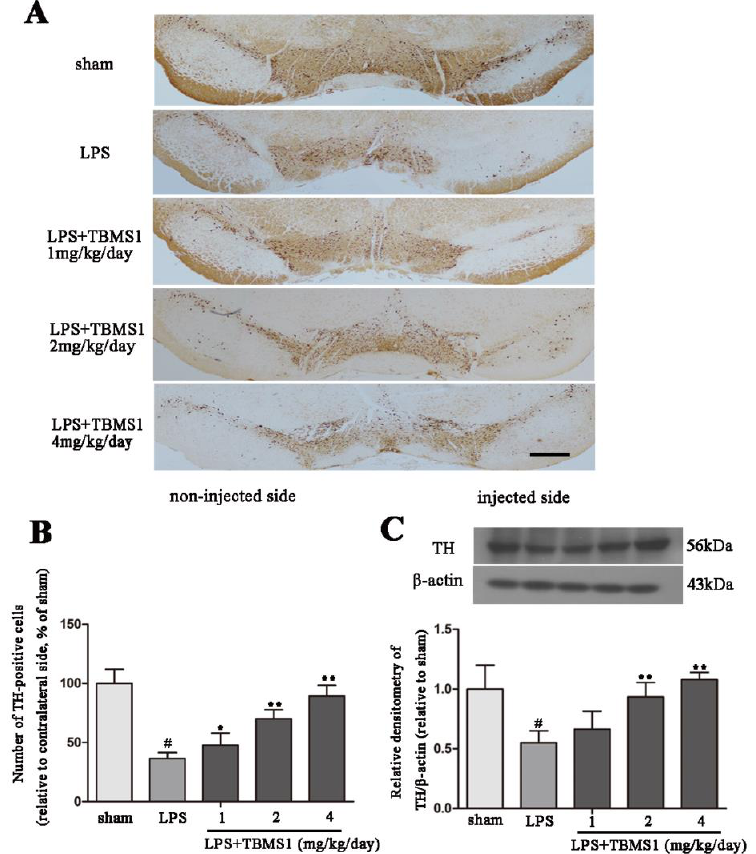
Figure 2. Protective effects of TBMS1 on dopaminergic neurons in the substantia nigra (SN) in LPS-injected PD rat model. PD rat models were anesthetized and sacrificed to obtain the midbrain after 4 weeks’ TBMS1 treatment. ( A ) Tyrosine hydroxylase (TH)-positive cells in 40× Fluorescence microscope via immunohistochemistry, the scale bar represents 100 μm ( n = 5 per group); ( B ) TH-positive cells number (TH-positive cells on the injected side versus the TH-positive cells on non-injected side) was blind-counted by five individuals; ( C ) The protein level of TH was tested by western blotting. The results are shown as mean ± SD of three independent experiments. # p < 0.01 versus the sham-operated group. * p < 0.05 and ** p < 0.01 versus the TBMS1-untreated LPS-injected group, and statistical significance was determined by